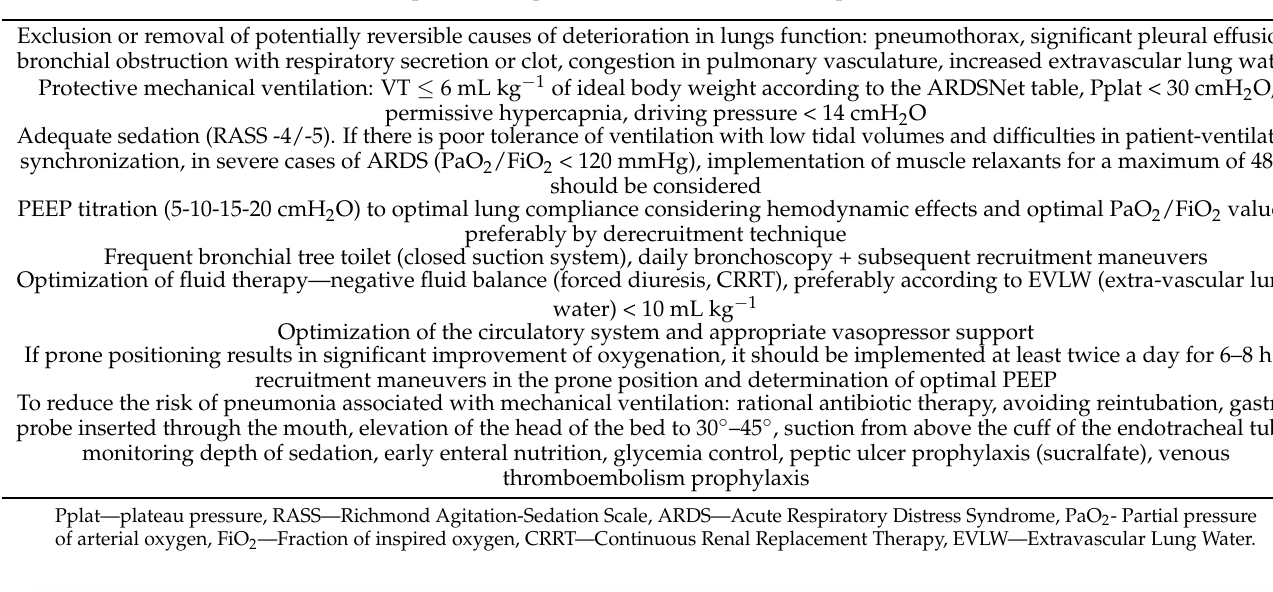
Table 1. Optimization procedures before VV-ECMO qualification [31].